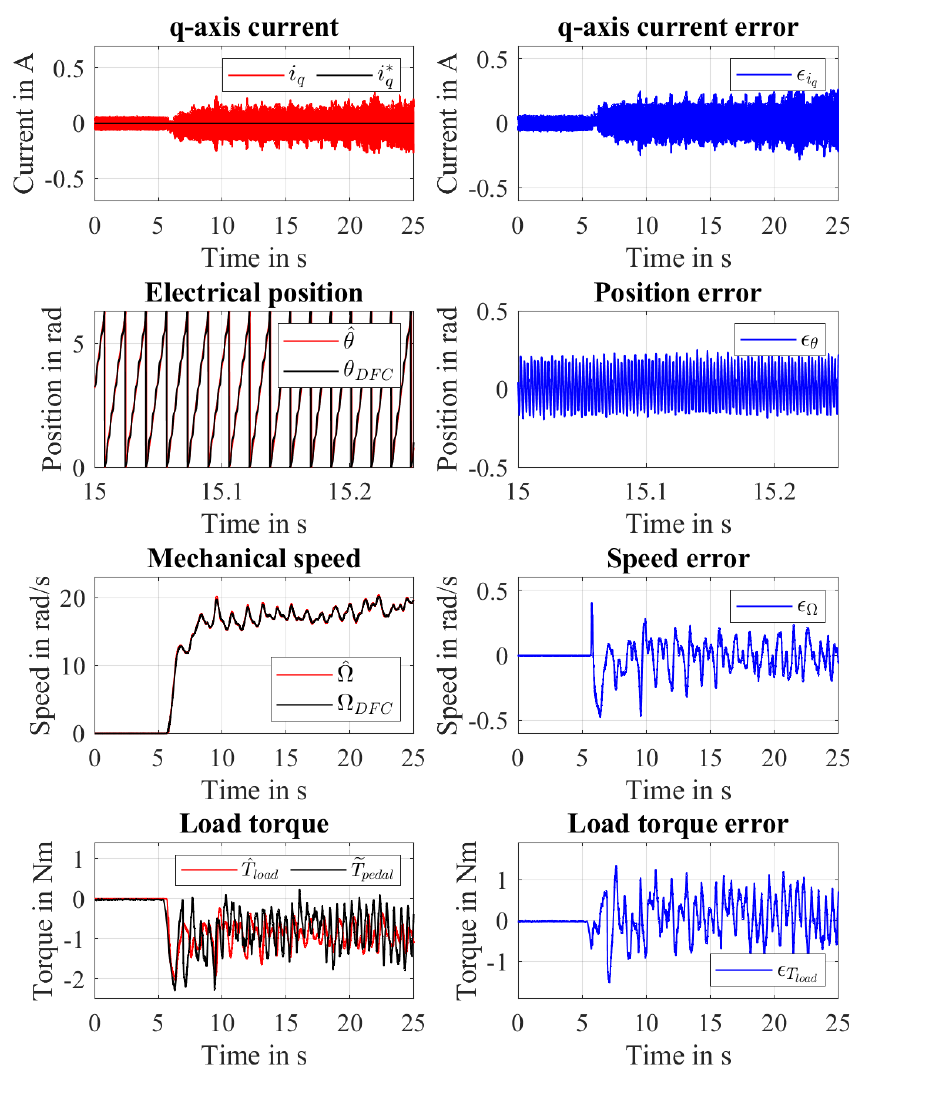
Figure 12. Experiment E3 : Applied pedalling torque with no additional torque